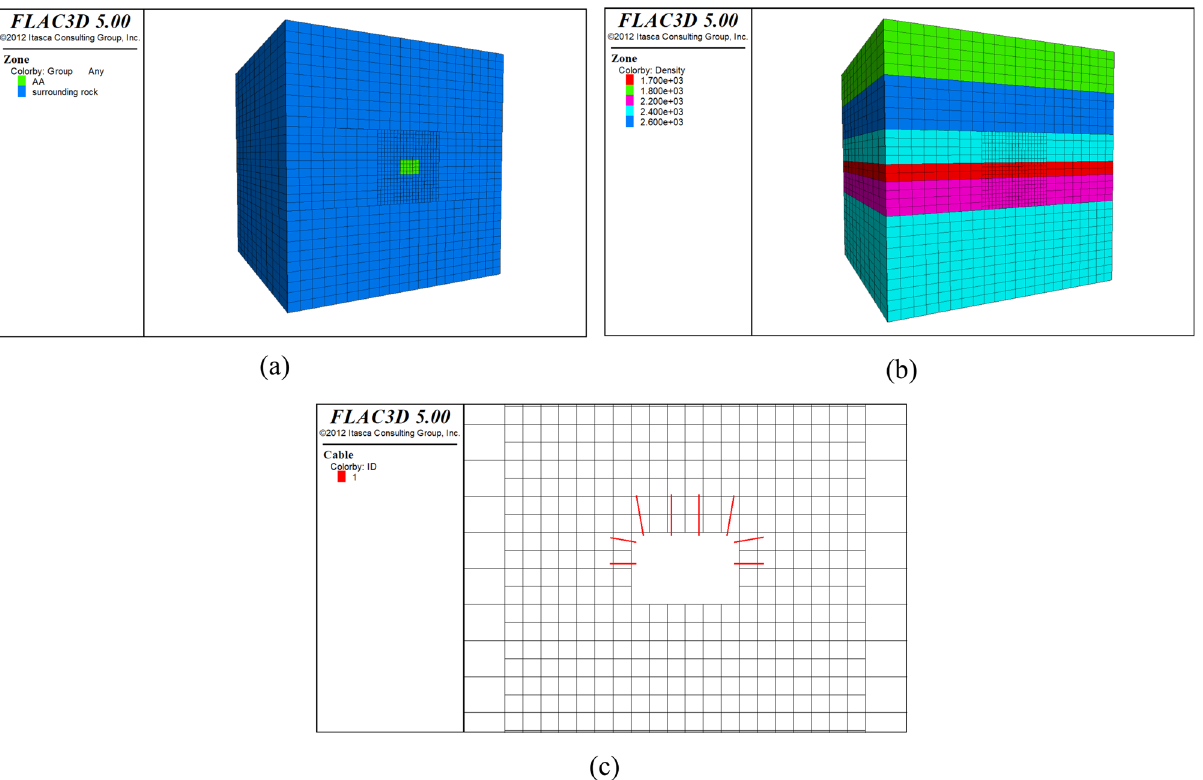
Figure 7. Numerical calculation model of roadway: ( a ) Meshing and grouping; ( b ) Density distribution; ( c ) Suspension roof